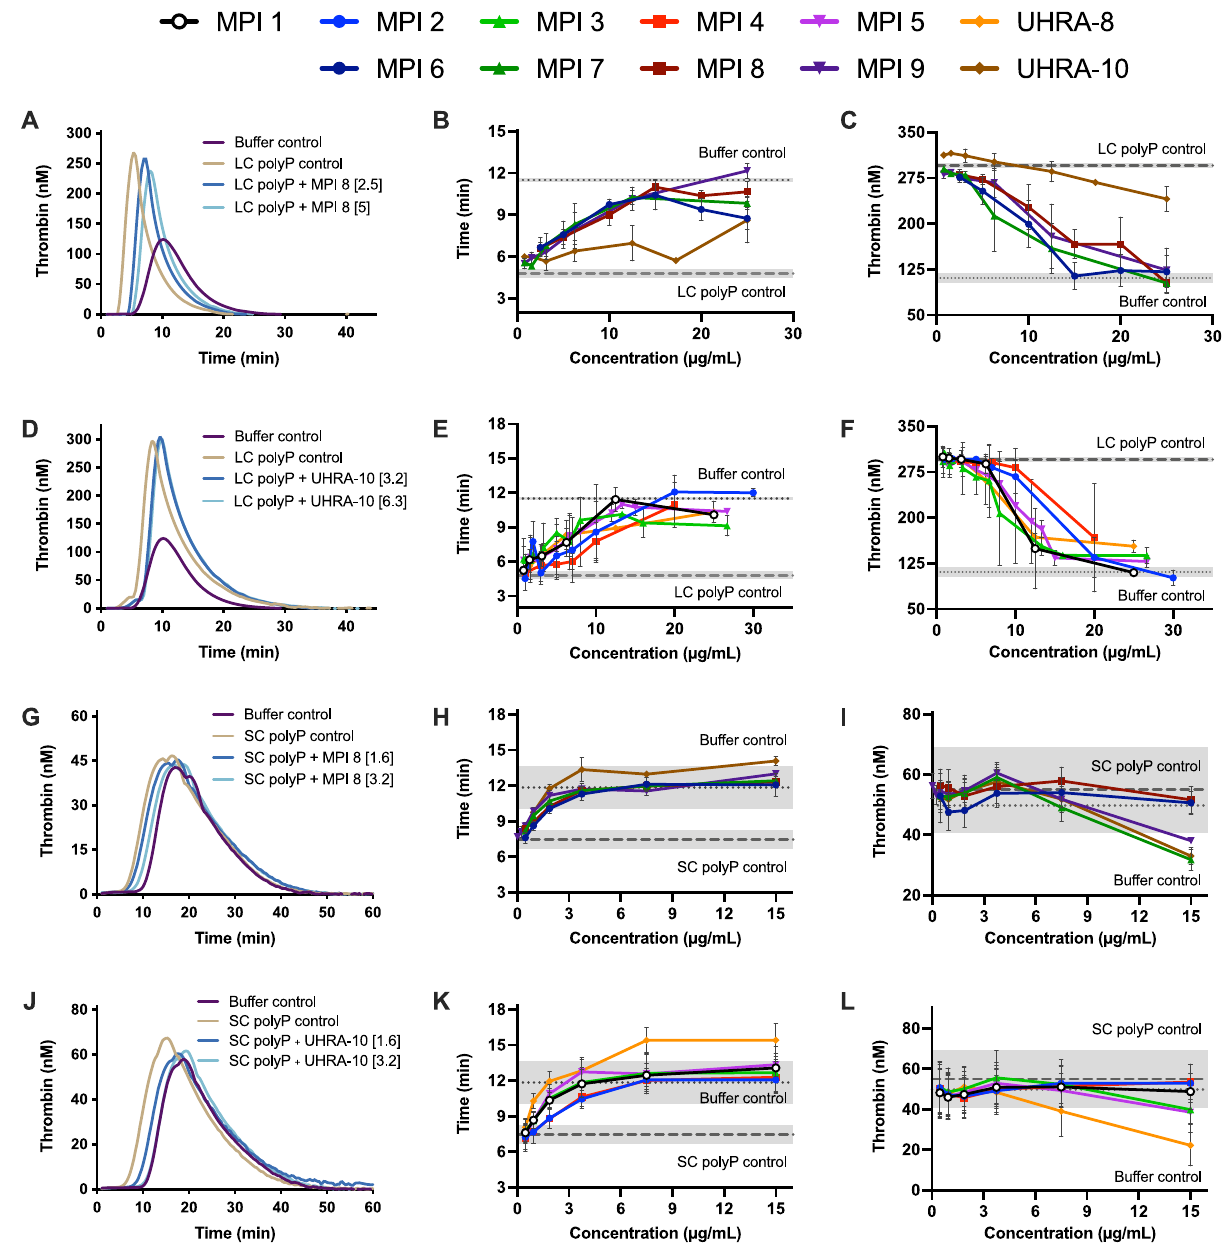
Fig. 3 | MPI library inhibits both bacterial-sized polyP and platelet-sized polyP procoagulant activity in vitro. A – C inhibition of LC polyP by MPI 6 — MPI 9.